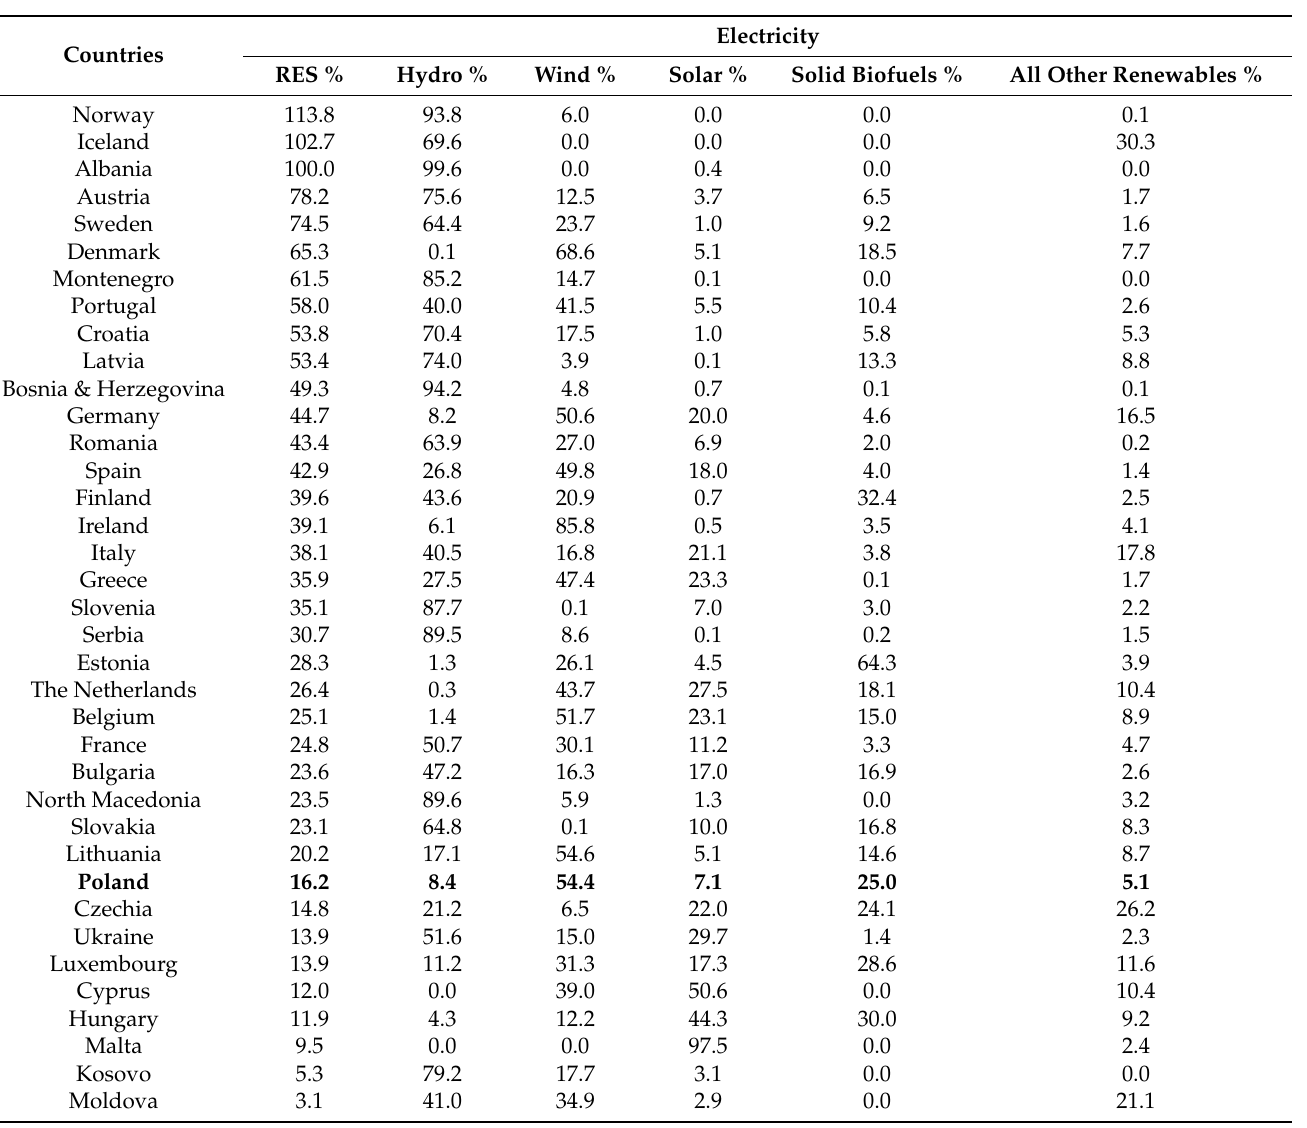
Table 3. Share of RES in total production of electricity and share of main RES sources in total RES in European countries in 2020. Source: own elaboration on the basis of data from https://ec.europa.eu/ eurostat/web/energy/data/shares, accessed on 11 November